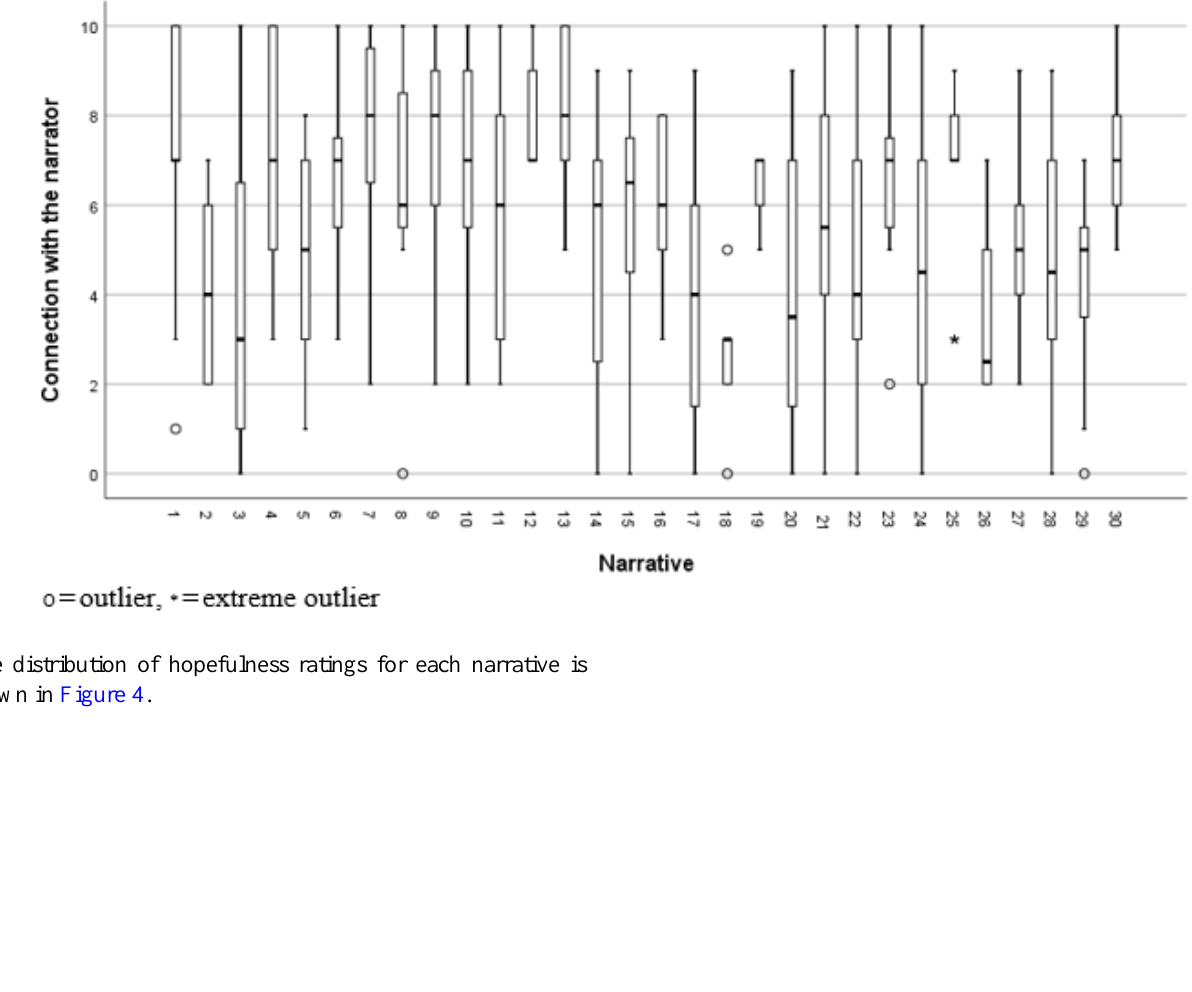
The distribution of narrator connection ratings for each narrative is shown in Figure 3. Figure 3. Ratings by participants (N=40) of connection with the narrator.